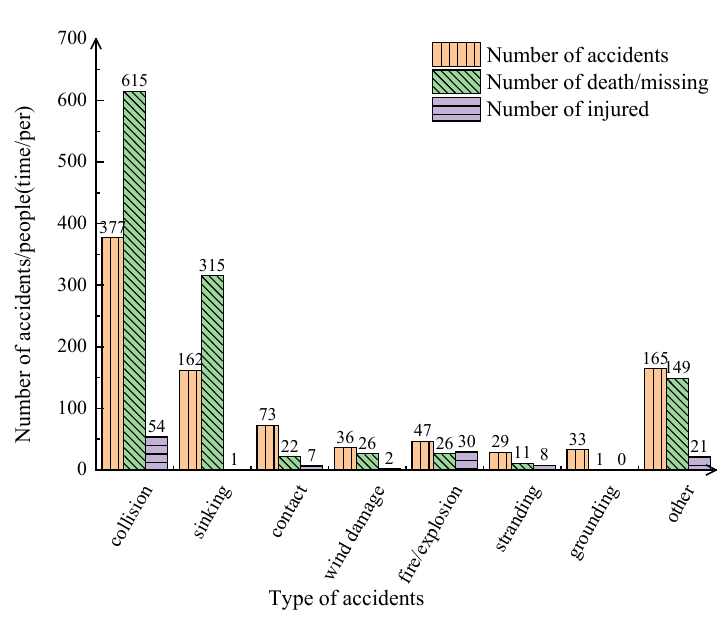
Figure 4. Numbers of total accidents, deaths and missing, and injured.